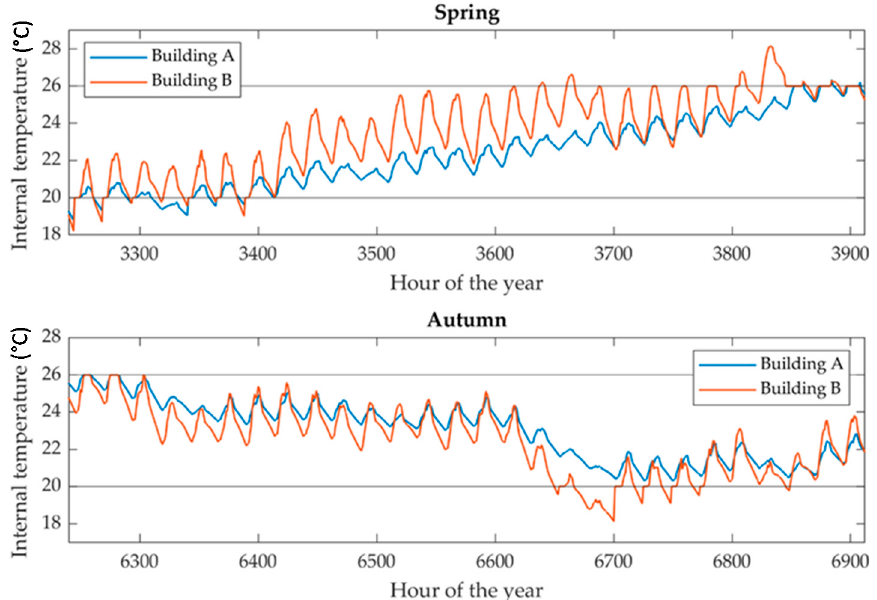
Figure 5. Internal temperature profiles for the two buildings during mid-seasons.